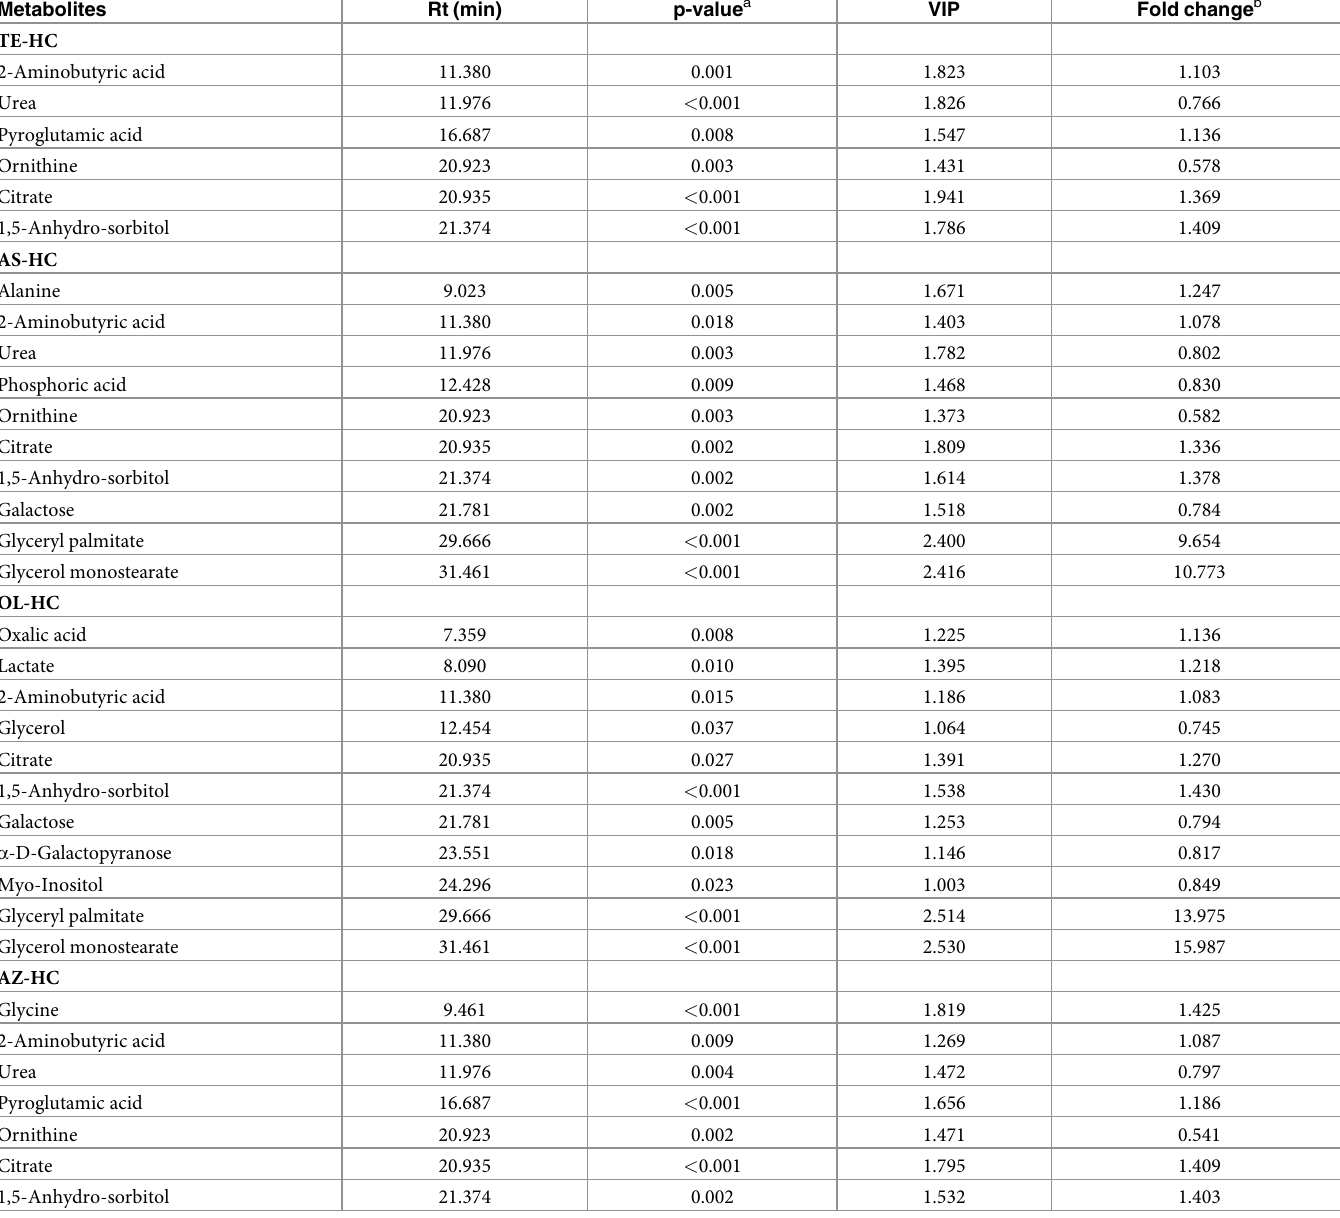
(TCA). Based on knowledge of the selected biomarkers and disordered metabolisms, a map of the SA male infertility-related metabolic pathways was constructed (Fig 5). Table 1. Statistical analysis of biomarkers based on PLS-DA and ANOVA between 4 SA subgroups and HC respectively.